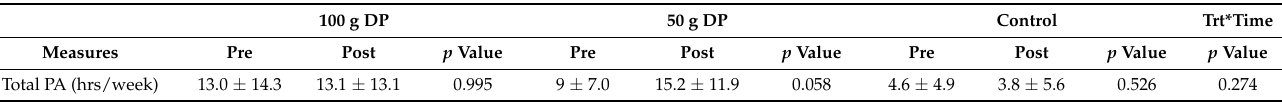
Table 2. Anthropometric and vital measurements at baseline (Pre-) and 3 months (Post).